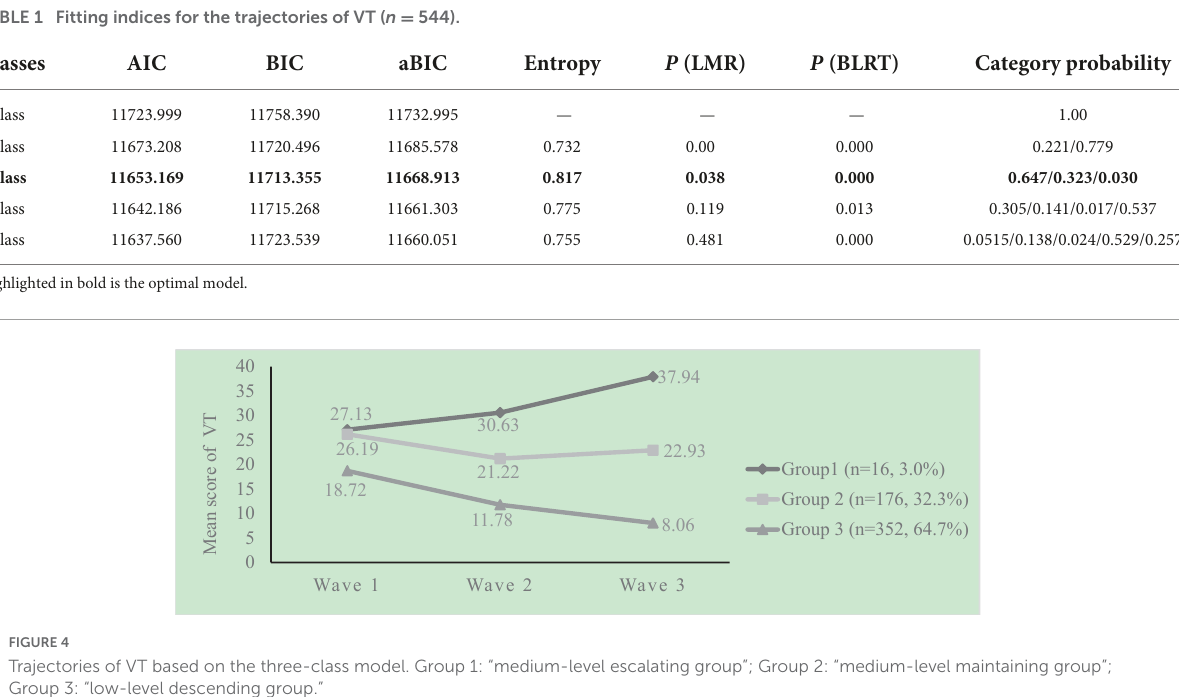
of the epidemic in residence, and level of resourcefulness at baseline were not the predictors for the trajectories of VT, whereas variables of gender, age, and mental health status at baseline were statistical significance ( Supplementary Table 3 ), and were included in multiple logistic regression ( Table 2